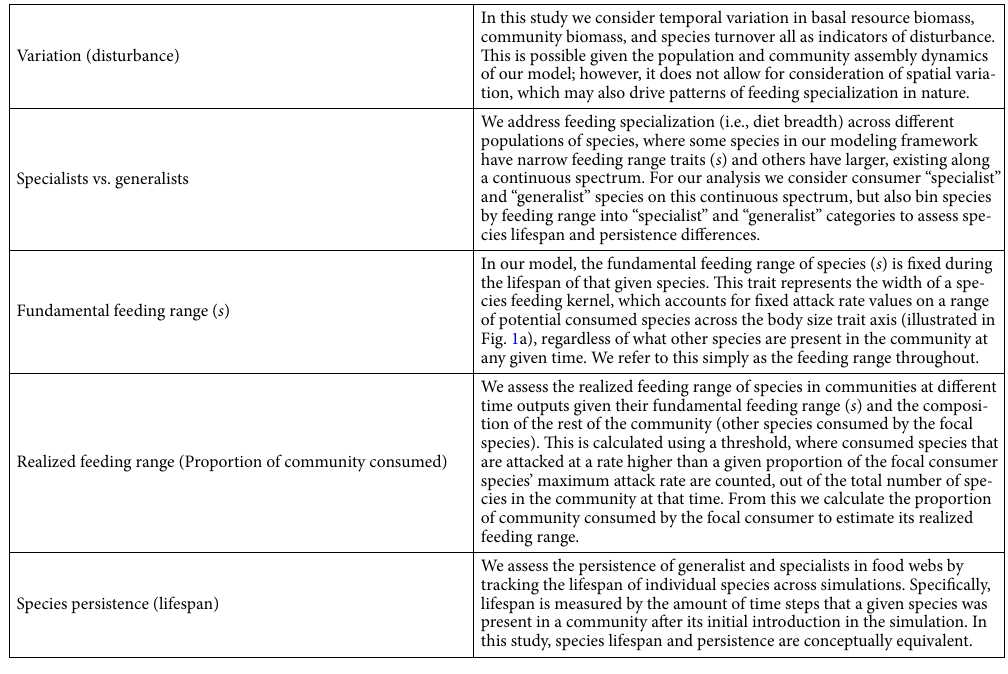
Table 1. Terminology and